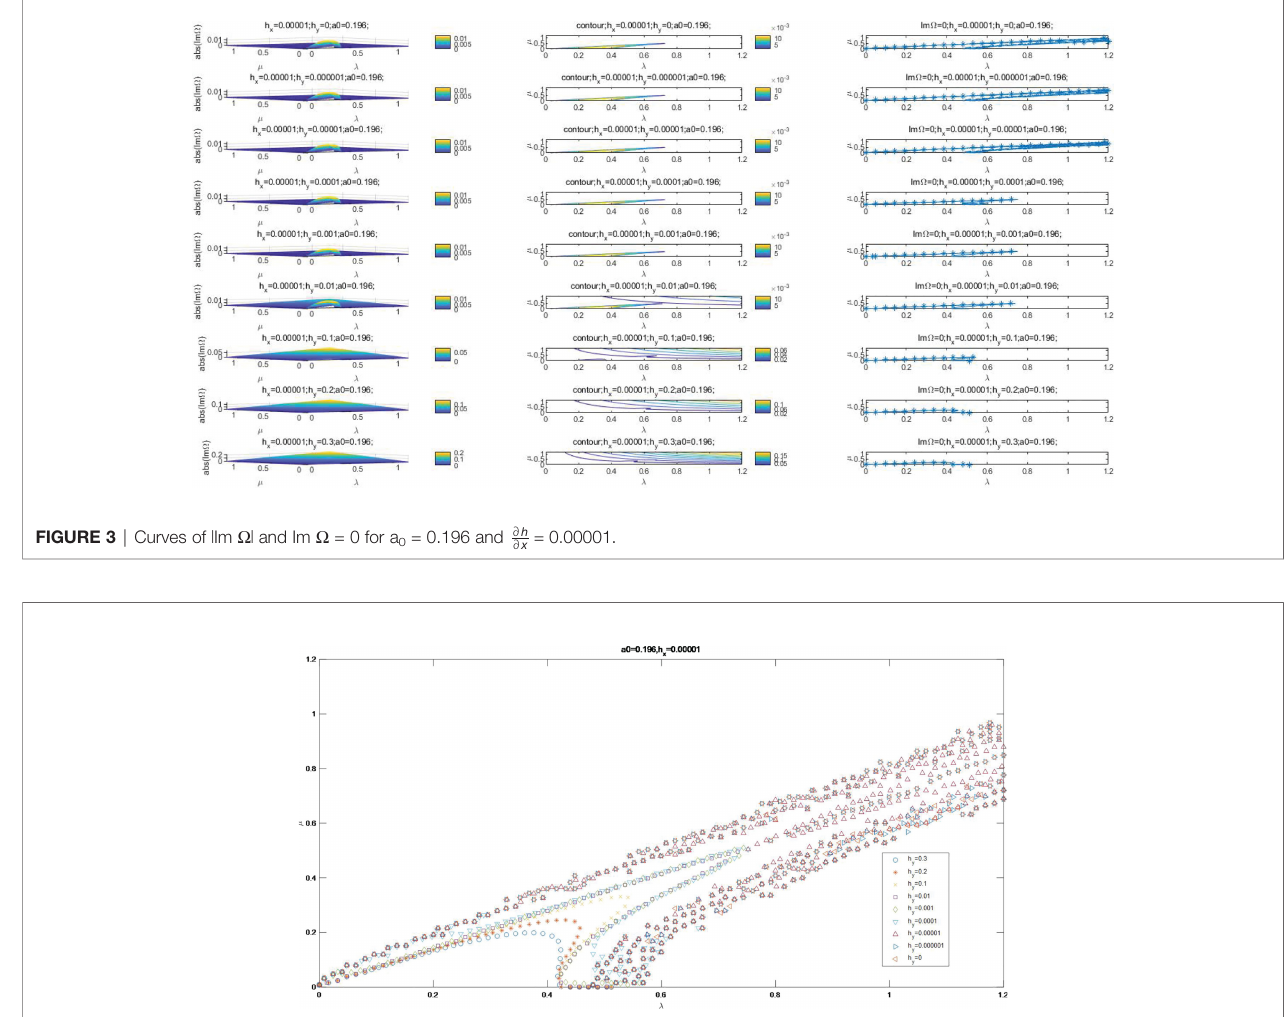
FIGURE 4 | The magni fi ed curves of Im W = 0 for a 0 = 0.196 and ∂ ∂ h ∂ x = 0 :